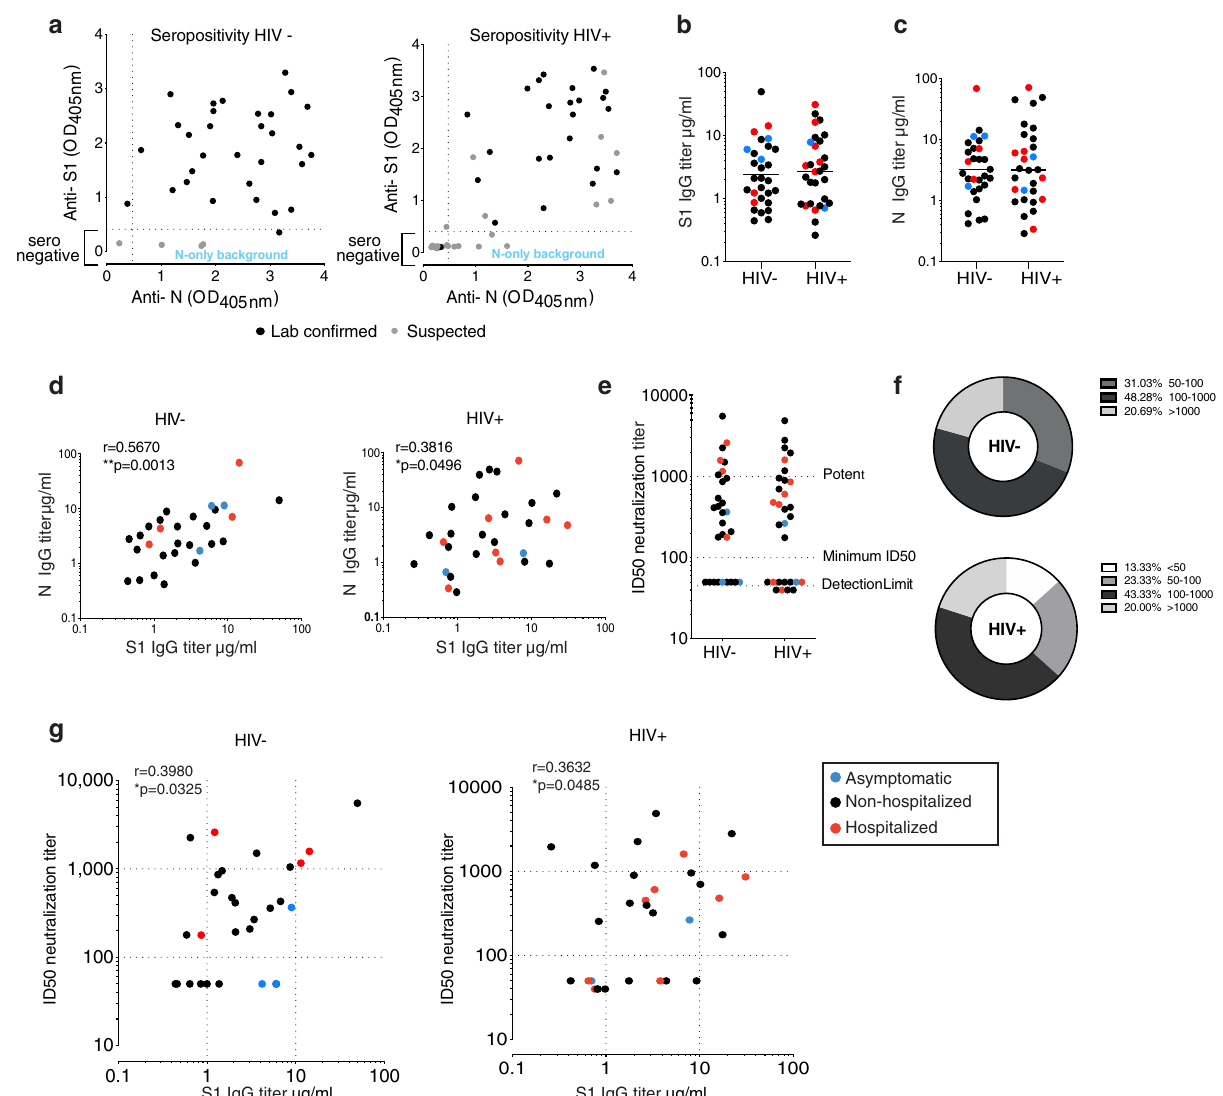
Fig. 1 Antibody response in HIV-positive and -negative donors recovered from COVID-19 disease. a Seropositivity screen of plasma samples for antibodies against the external Spike antigen, using a recombinant Spike S1 1 − 530 subunit protein (S1), and against the full-length internal Nucleoprotein (N) antigen to con fi rm prior infection in HIV-negative and -positive donors. A sample absorbance >4-fold above the average background of the assay was regarded as positive. Black dots denote laboratory-con fi rmed cases and gray dots suspected/household contacts. b Comparison of S1 IgG and N IgG antibody titers in HIV-negative ( n = 29) and c HIV-positive donors ( n = 30). Red dots: hospitalized cases; black dots: mild (non-hospitalized cases); blue dots: asymptomatic cases. Plots show geometric mean. d Correlation between S1 IgG and N IgG titers in HIV-negative and -positive donors. e Neutralization titers in HIV-negative ( n = 29) and -positive ( n = 30) donors. Dotted lines indicate detection limit, minimum ID50 and potent levels >1000. f Proportion of HIV- negative ( n = 29) and -positive ( n = 30) donors with neutralizing antibodies within the given ranges. g Correlation between S1 IgG titers and neutralization titers in HIV-negative and -positive donors. The non-parametric Spearman test was used for correlation analysis. Two-tailed Mann – Whitney U test was used for group comparisons. * p < 0.05, ** p < 0.01. across the two study groups in terms of the number of individuals SARS-CoV-2 antibodies to S1 and N at 146 DPSO (101 − 220), with high potency, low potency or no neutralizing activity (<50 whereas none of the suspected/household contacts in this group ID50) (Fig. 1f), which correlated with anti-S1 IgG levels (Fig. 1g). (0/4) had quanti fi able titers (DPSO median 200; range 125 − 203) A range of neutralizing antibodies (nAb) was detected in the (Fig. 1a − c). S1 and N titers were found to be comparable between groups, with some samples exhibiting strong neutralization the HIV-positive and -negative groups (Fig. 1b, c) and correlated despite low S1 titers irrespective of disease severity (Fig. 1g). with one another, although levels were heterogenous among No association was observed between S1 binding titers and age donors as previously observed (Fig. 1d). according to gender in the two groups (Supplementary Fig. 1c). A To determine whether the SARS-CoV-2 antibodies generated weak positive correlation was seen between neutralization levels are able to inhibit SARS-CoV-2 infection, we employed a serum and age according to male gender in the HIV-positive group, neutralization assay with pseudotyped SARS-CoV-2, to calculate where subjects were older and females were notably under- the 50% inhibitory serum dilution (ID50) 28 . Overall, we detected similar neutralization levels (Fig. 1e) and comparable pro fi les represented (Supplementary Fig. 1d). Neutralization levels did NATURE COMMUNICATIONS| (2021) 12:5839